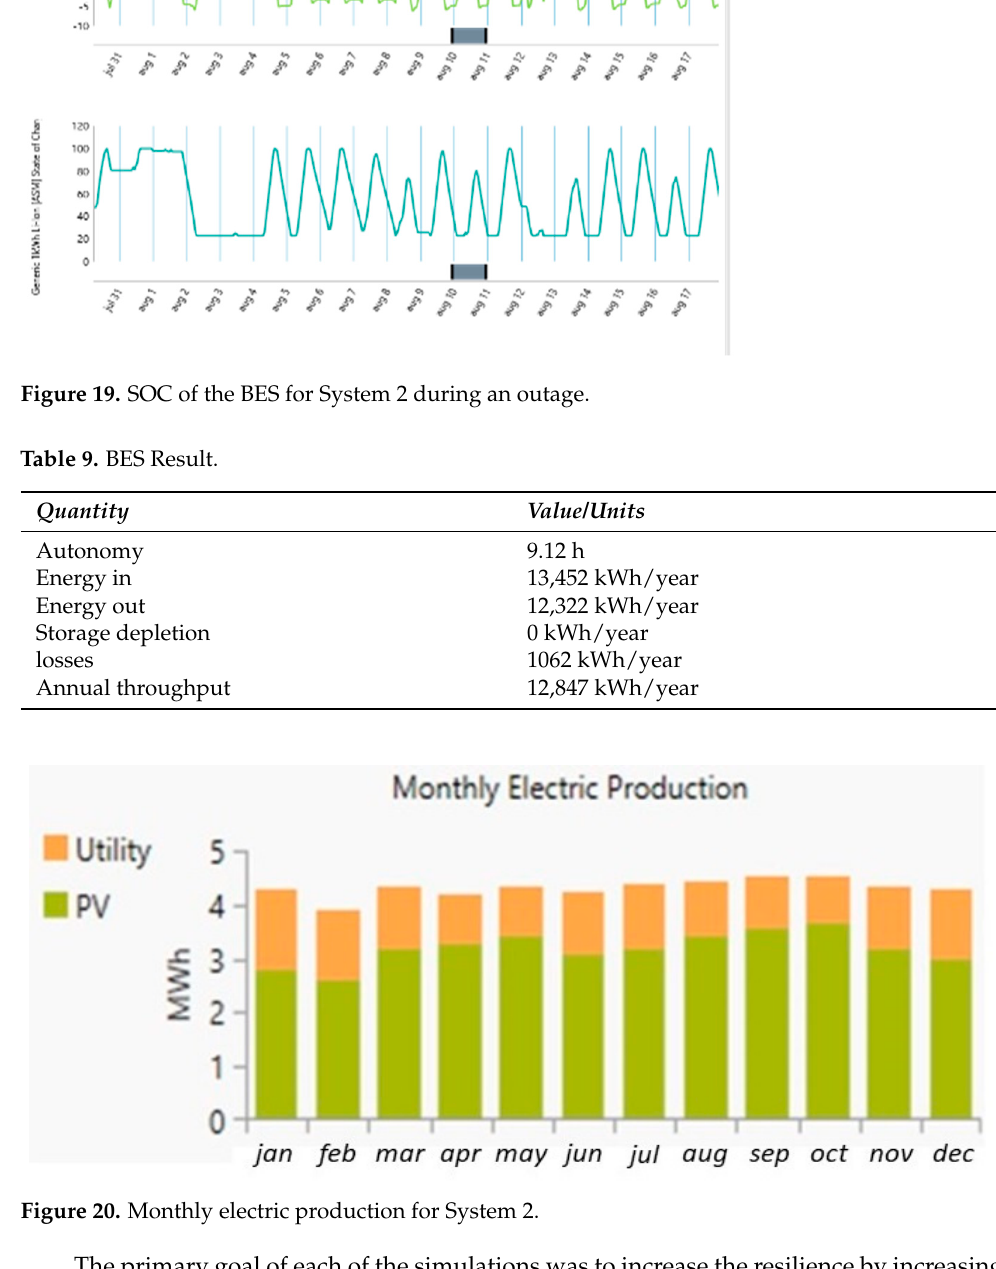
Table 8. Parameters for SYSTEM 2.